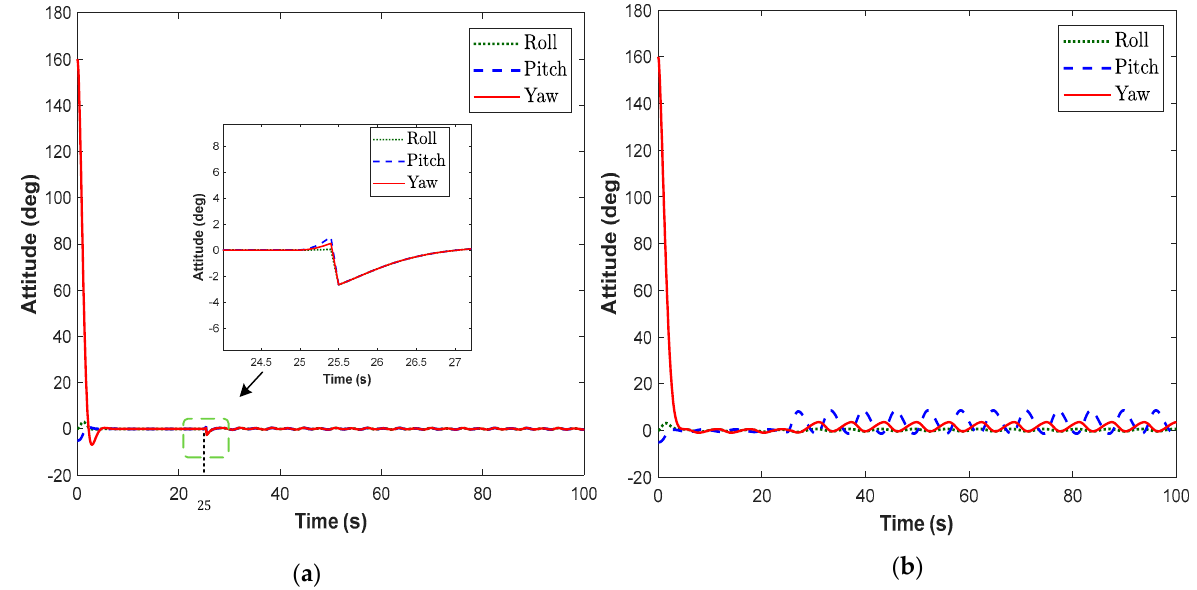
Figure 3. Comparison between fault-tolerant control effect and PID control effect. ( a ) Description of fault-tolerant control effect; and ( b ) description of PID control effect.